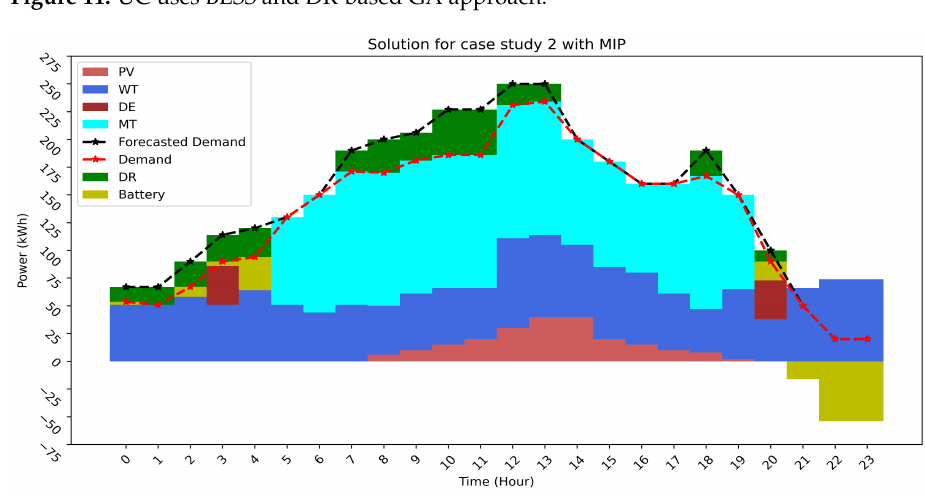
Figure 12. UC uses BESS and DR-based MIP approach.